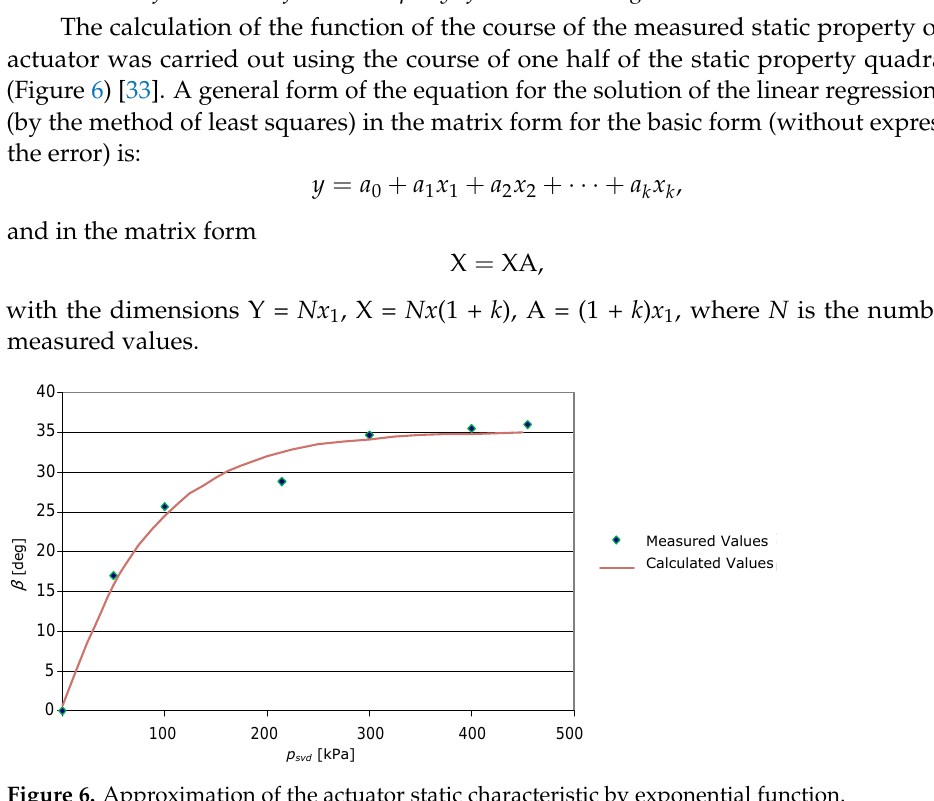
Figure 6. Approximation of the actuator static characteristic by exponential function.